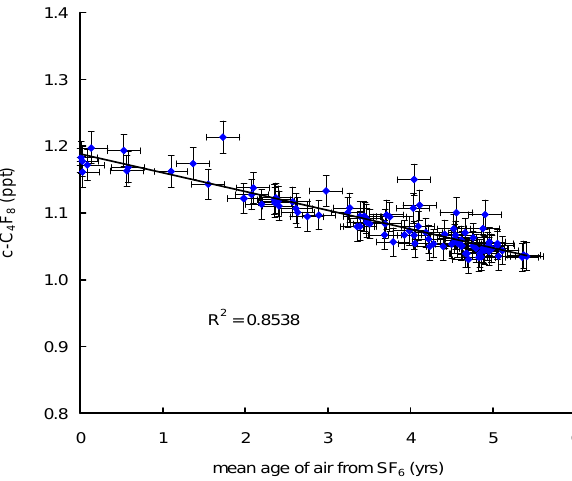
Fig. 3. Measurements of c-C 4 F 8 from CARIBIC flights at 10-12 km altitude between Germany and South Africa in October 2009 and November 2010. Error bars show the mean analytical precision (1 σ) .